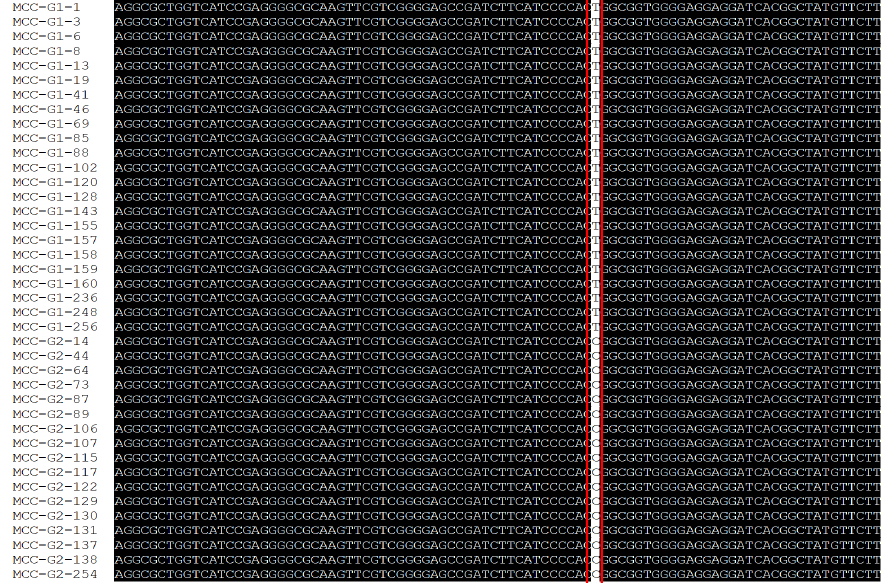
Figure 5. Sequencing and identification of CAPS loci of CCD7 ‐ B gene of wheat micro ‐ core collections in China. The red box indicates the Sgr AI enzyme digestion site. Furthermore, the distribution and frequencies of CCD7 ‐ B1 and B2 alleles in the MCC ‐ CNs were studied among the 10 wheat ‐ growing regions of China (Table 2). CCD7 ‐ B1 and CCD7 ‐ B2 both occurred in all 10 wheat ‐ growing regions of China. CCD7 ‐ B1 was widely distributed among the wheat varieties grown in the Yellow and Huai River Valley winter wheat region (16.79%) and Northern winter wheat region (8.78%), while CCD7 ‐ B2 was ley winter wheat region (8.78%). The Northern winter wheat region (13/32, 40.6%) and Yellow and Huai River Valley winter wheat region (29/64, 45.3%) contained more im ‐ proved wheat varieties (bred cultivars, Table S1), whereas the Middle and Low Yangtze valley winter wheat region (23/31, 74.2%) had more rural wheat varieties (landraces), in ‐ dicating that CCD7 ‐ B1 had been effectively selected during the breeding process. Table 2. The distribution and frequencies of CCD7 ‐ B alleles in Chinese wheat micro ‐ core collections. Wheat Growing Regions of China